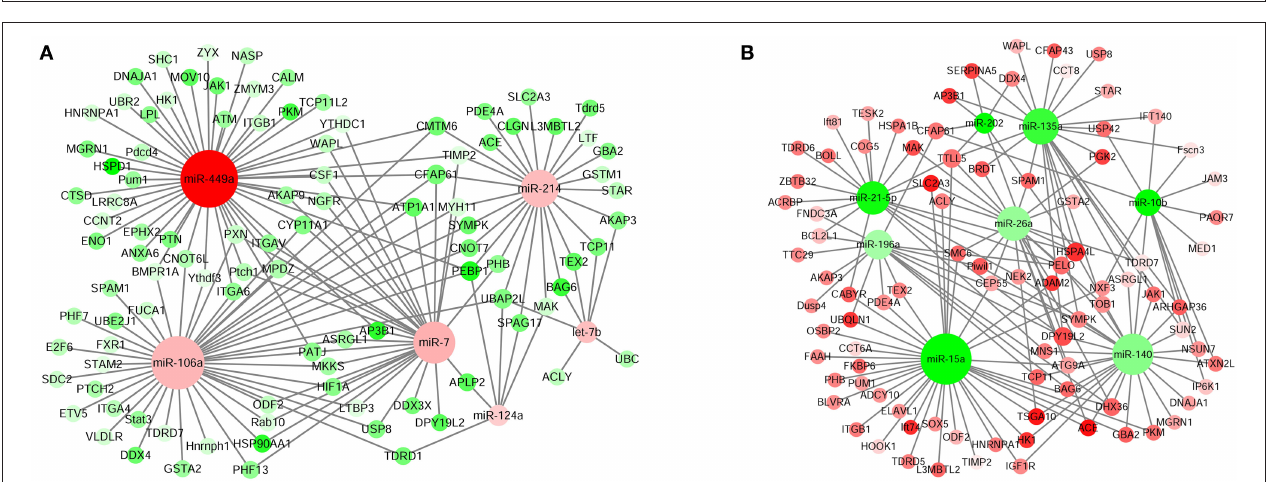
FIGURE 4 | miRNA-mRNA interaction network related to testis development of Sika Deer. (A) Up-regulated miRNAs and down-regulated target genes related to testis development. (B) Down-regulated miRNAs and up-regulated target genes related to testis development. The up-regulated miRNAs or genes were displayed as red circles, and the down-regulated miRNAs or genes were displayed as green circles.